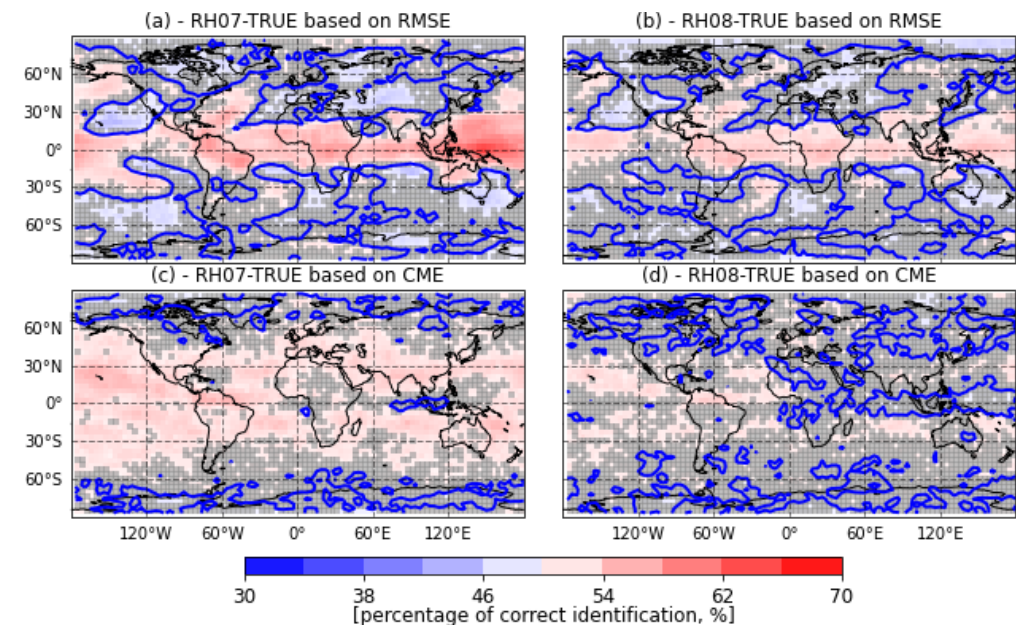
Figure 9. As in Fig. 8 but for the experiments in which the catalogs and observations have been standardized with respect of their respective climatological variability (see the text for